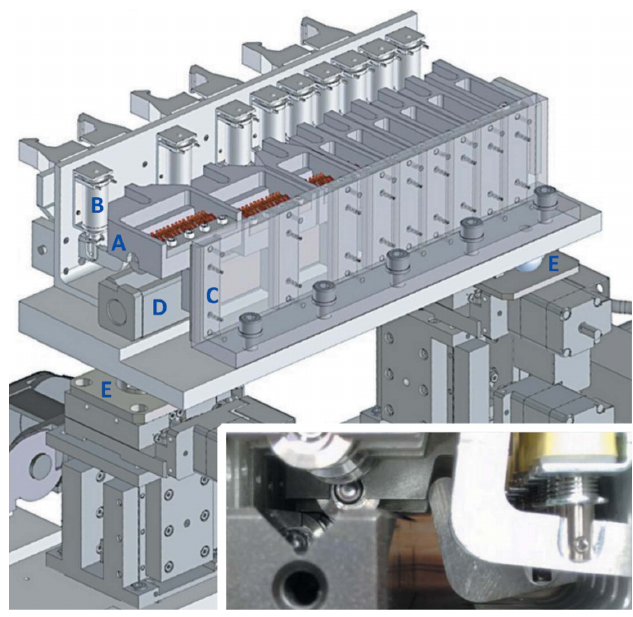
Figure 1 CRL transfocator at LiX. The lenses are organized into nine lens holders. Each holder (A) can be moved into or out of the beam using a bistable solenoid (B) and guided by a linear rail (C). In the ‘in’ position, the lenses are pushed by the finger spring (copper-colored) installed in the holder against, and therefore aligned by, a Vee block (D). The transfocator is supported on either end by a stack of x – y stages via kinematic mounts (E). The inset is a photograph of the components in the